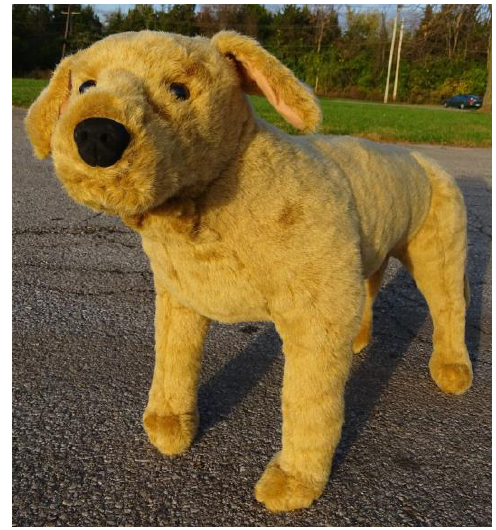
Figure A1. Photograph of life-size model of a Labrador retriever used for the Model Dog Test.